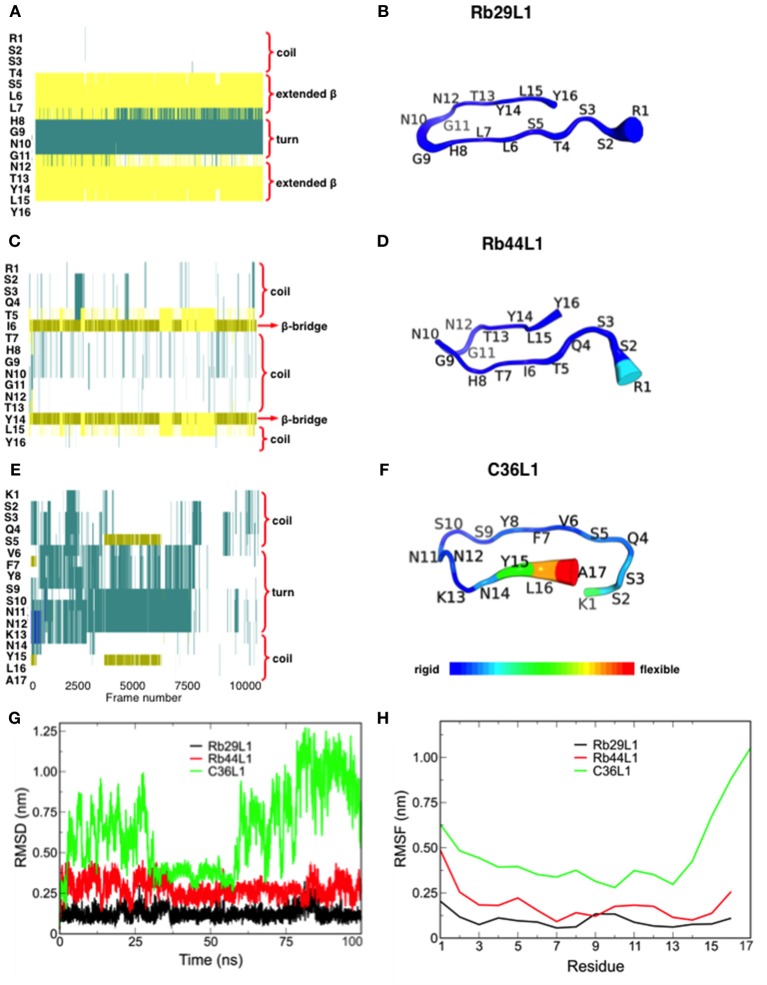
Secondary structure assignment during molecular dynamics and structural analysis of L1-CDRs. (A,B) Rb29L1 assumes a stable β-hairpin conformation during MD, showing a well established β-sheet between residues 5SLL and 13TYL; (C,D) Rb44L1 shows a recurrent β-bridge between residues 5TI and 14YL; (E,F) C36L1 presents the most flexible conformation, in its majority composed by turn and coil. Secondary structure color code: turn, in green; extended conformation (β-sheet), in yellow; isolated bridge, in gold; 3-10 helix, in blue; coil, in white; (G) root-mean-squared deviation of backbone atoms of Rb29L1, Rb44L1, and C36L1. Rb29L1 remains nearly at the same conformation during all MD, an effect also seen for Rb44L1, although with less intensity. C36L1, nonetheless, presented a great conformational variation; (H) root-mean-squared fluctuations of Cα atoms of Rb29L1, Rb44L1 and C36L1. Cα fluctuation, or flexibility, follows RMSD pattern. Rb29L1 presents a rigid structure while Rb44L1 and C36L1 are more flexible, the latter more pronounced.